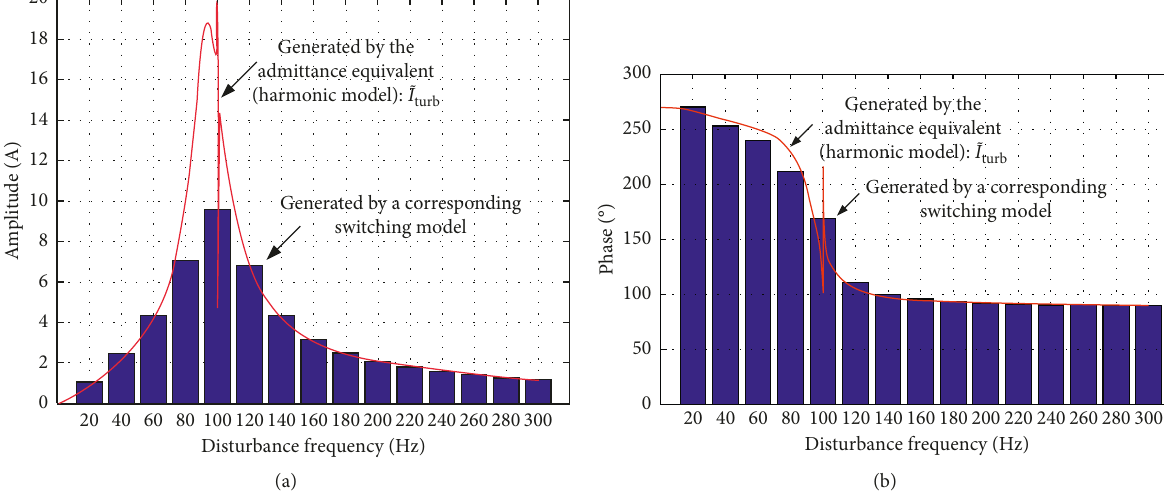
Figure 13: Spectrum of turbine output current with a 0.005p.u harmonic disturbance on the output voltage terminal of the single wind � ± 50 kV). (a) Magnitude of current harmonic. (b) Phase angle of current turbine converter ( V MVDC